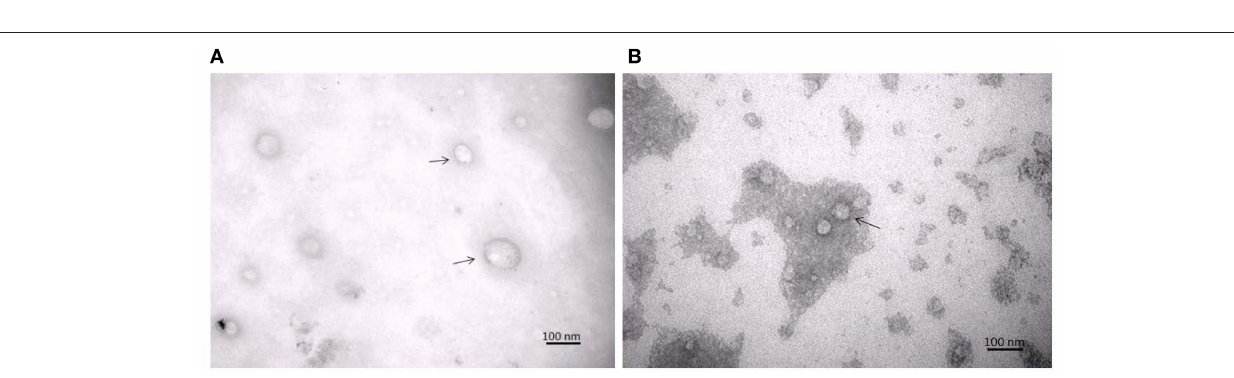
FIGURE 3 | Transmission electron microscopy of isolated plasma exosomes (A) and CSF exosomes (B) . Exosomes were marked by